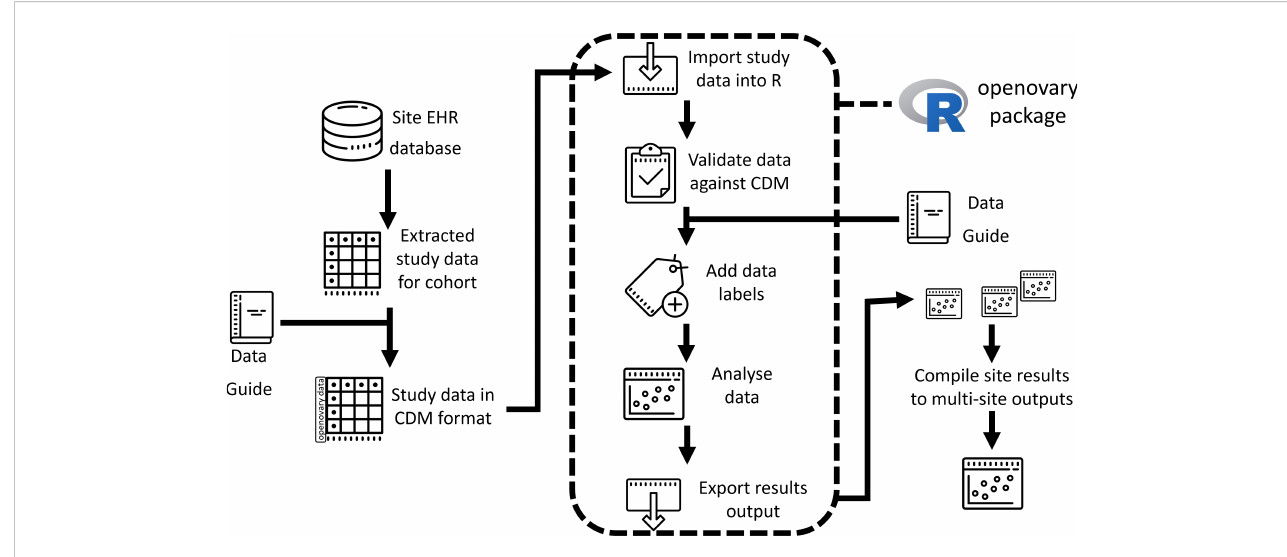
FIGURE 2 Summary schematic of the data access and analytical process at each study